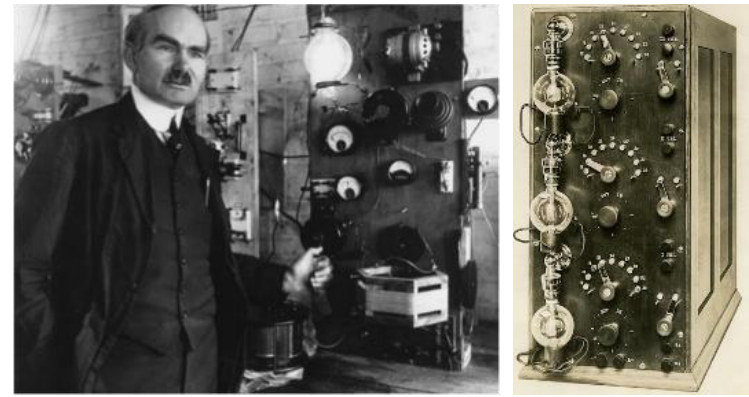
Fig. 9. Lee de Forest, Palo Alto (1915) and a general view of a three-stage audio amplifier at audions